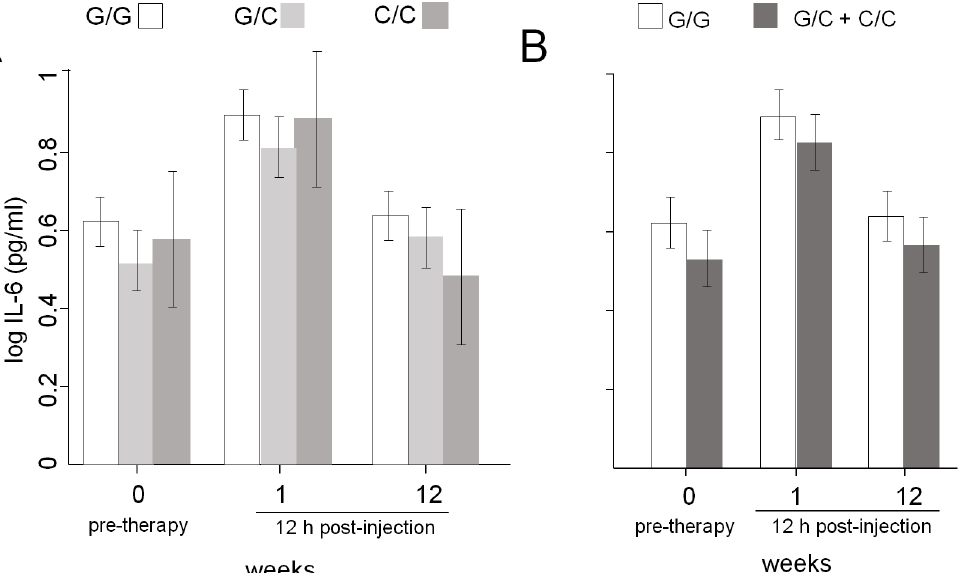
Fig 1. Average IL-6 levels in MS patients. (A) Average IL-6 levels in patients with the three indicated IL-6 genotypes. (B) Average IL-6 levels in patients bearing at least one allele with a C at position -174 of IL-6 gene and in those bearing only the allele with the G at the same position. 0 = samples collected just before the beginning of IFN β -1a therapy; 1 = samples collected at about 12 hours after the first injection; 12 = samples collected at about 12 hours (h) from the injection performed at 12 weeks of therapy.